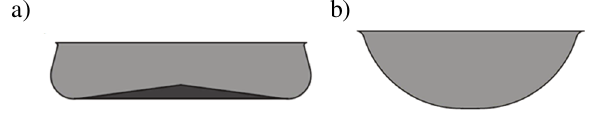
Fig. 2. Cross-section of combustion chambers used in the piston: a) omega, b) hemi-spherical